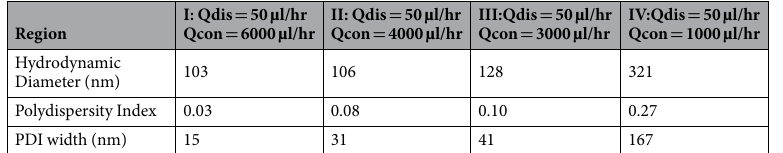
Table 1. Hydrodynamic diameter and PDI measured by DLS characterizing the broadness of the size distribution of PLGA NPs collected from the reservoir. Concentration of PLGA (Mw = 4000~15000 g/